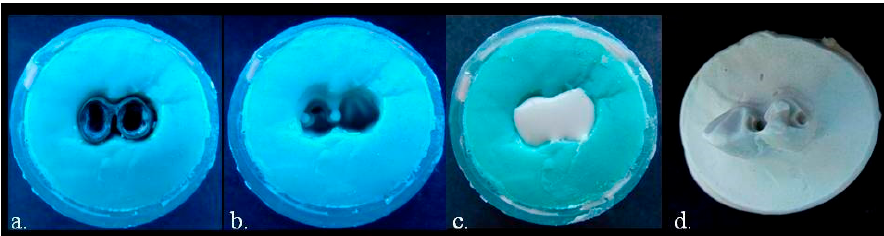
Figure 6. ( a ). Duplication of the Pa framework; ( b ). duplicating impression; ( c ). insertion of the refractory material in the duplicating impression; ( d ). refractory duplicate dPa.